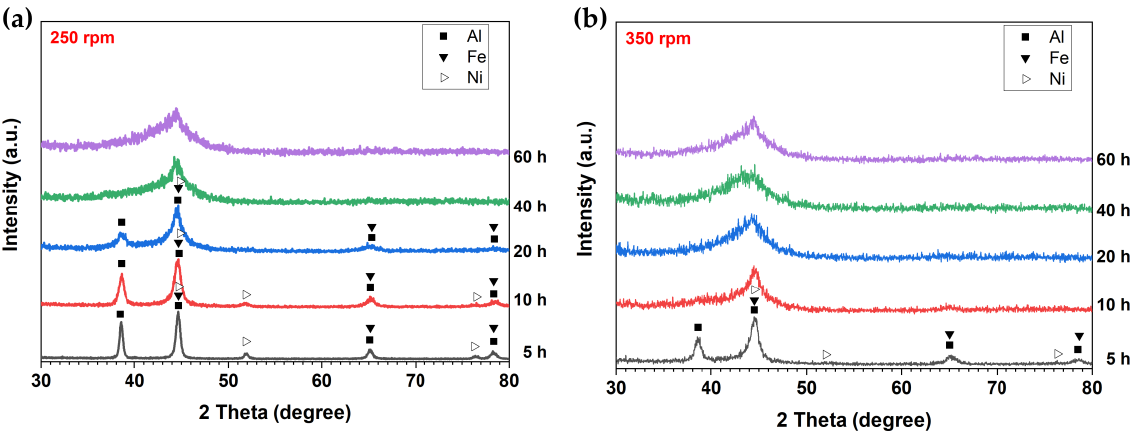
Figure 4. XRD patterns of Al 82 Fe 14 Ni 4 powders under different milling times at ( a ) 250 rpm and ( b ) 350 rpm.